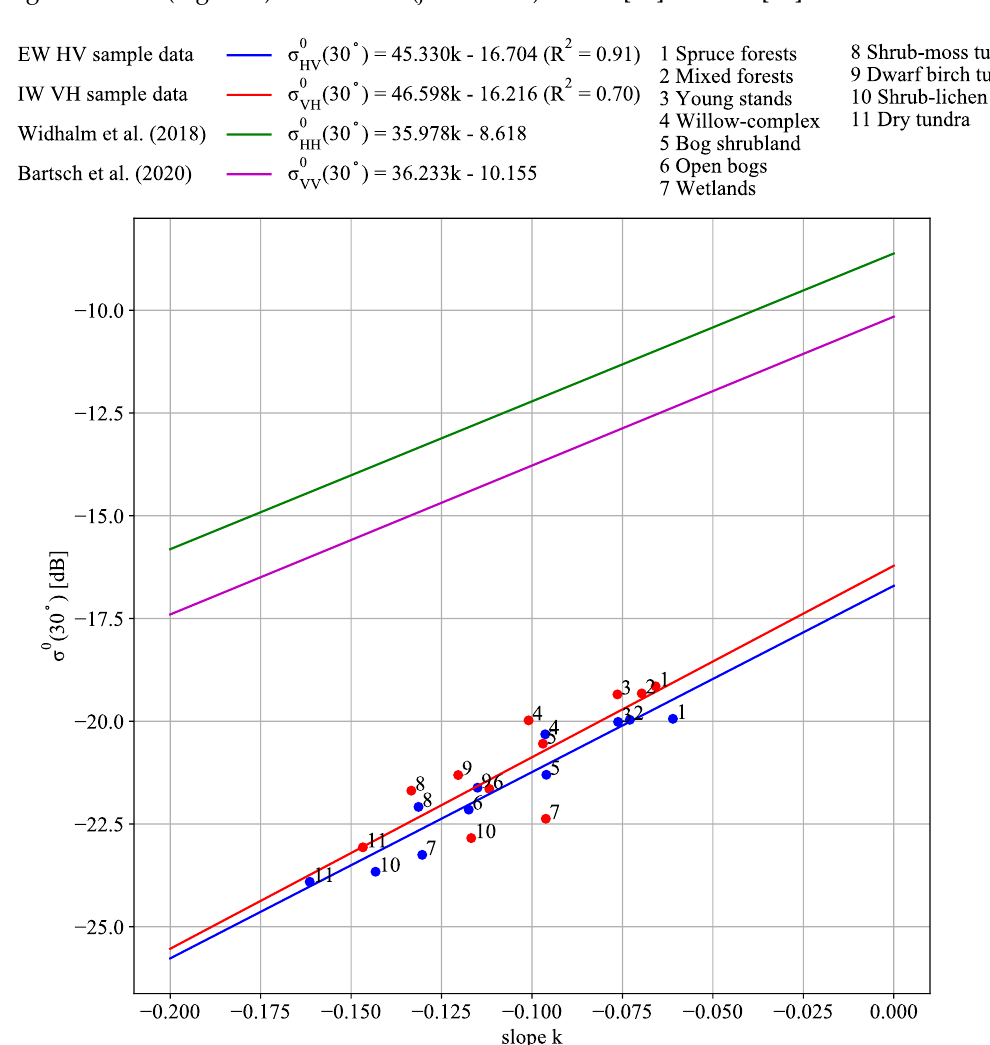
Figure 5. Sentinel-1-derived slope values k and σ 0 at 30 ◦ local incidence angle for most common landcover classes from the work in Virtanen et al. [10] for VH and HV polarization. These values are valid for scenes acquired under frozen conditions in high latitude environments. Previously published HH [53] and VV [51] functions are plotted for